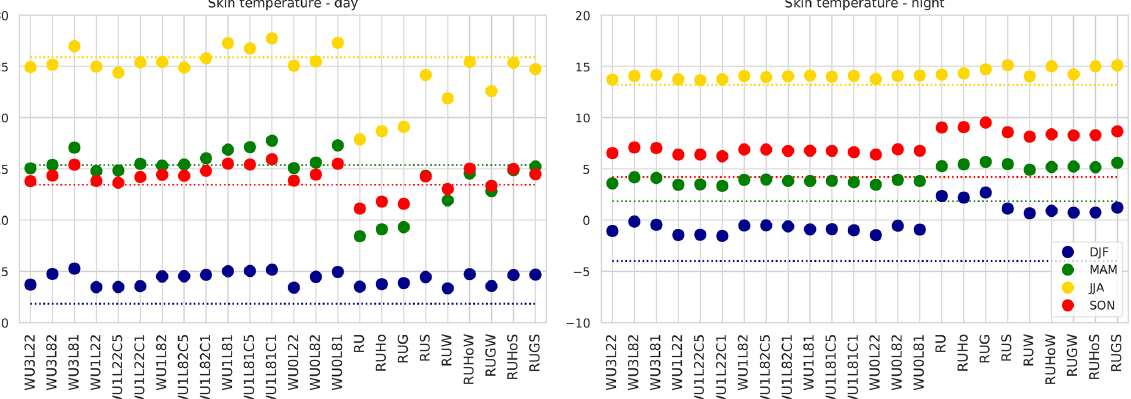
Figure 6. Averaged seasonal whole-domain surface temperatures ( ◦ C) in the daytime (includes 10:00 and 12:00UTC satellite and model data) and nighttime (02:00 and 21:00UTC) given by specific simulations and satellites (dotted line).